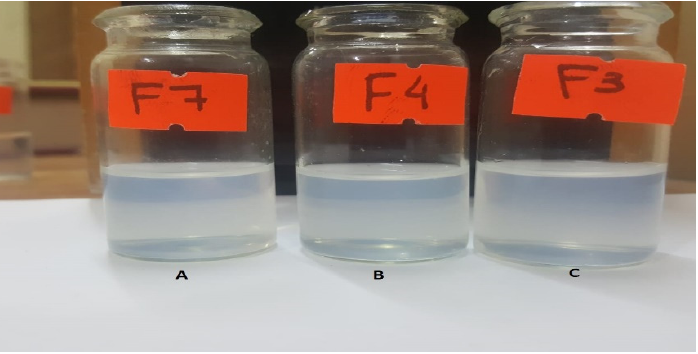
Figure 6. The selected formulations F7 ( A ), F4 ( B ) and F3 ( C ), were relevant in their dispersibility potential and transparency of the final emulsion as evident here.